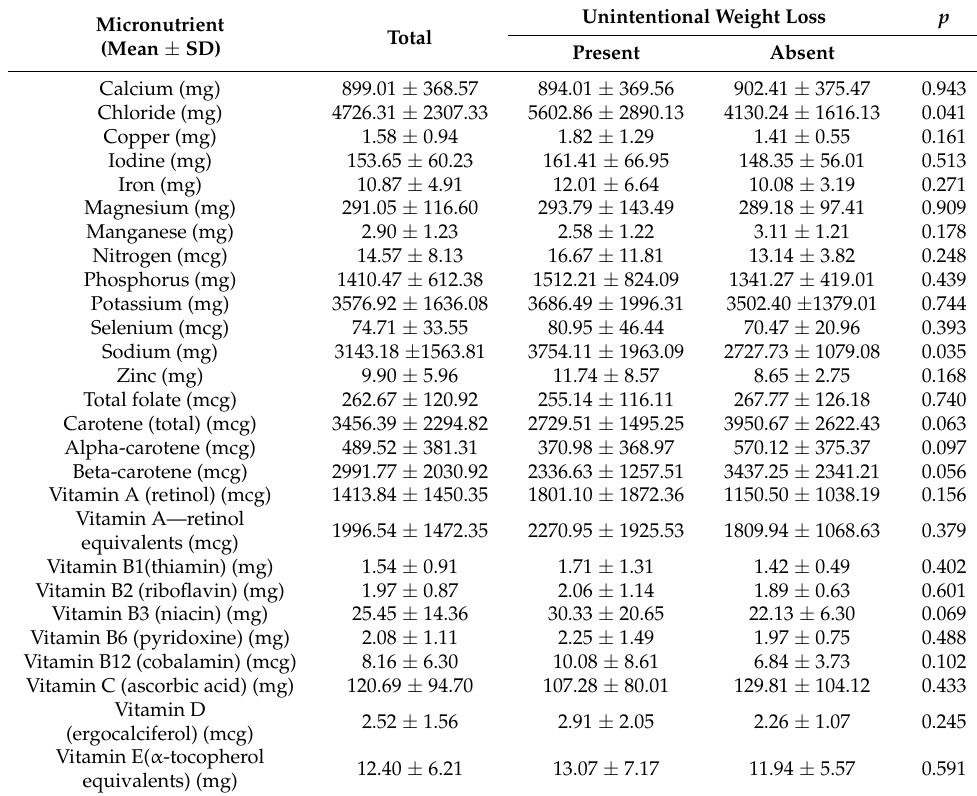
Table 5. The average daily consumption of micronutrients in the study group (total and with respect to the presence of weight